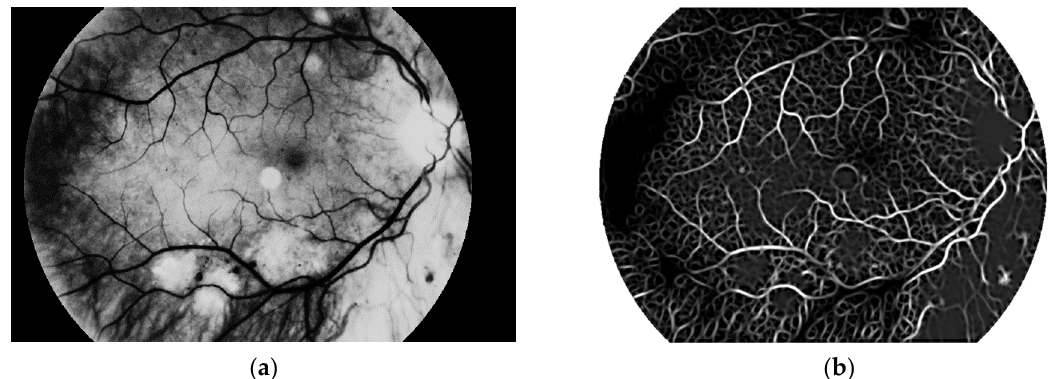
Figure 12. Image after ( a ) brightness correction and ( b ) Gaussian matched filter.